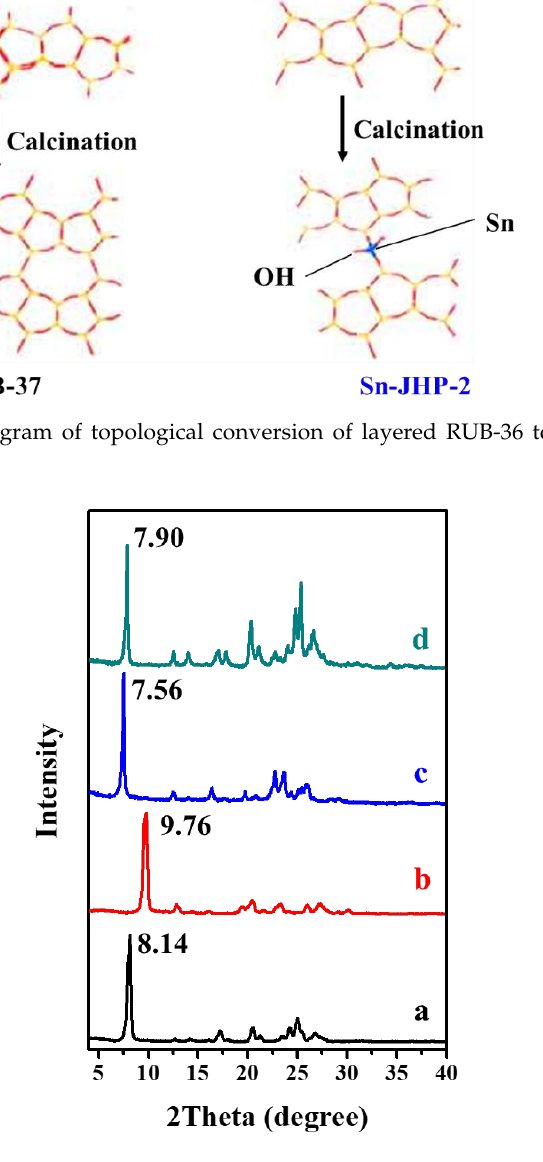
Figure 1. Schematic diagram of topological conversion of layered RUB-36 to RUB-37, Sn-JHP-1 and Sn-JHP-2.